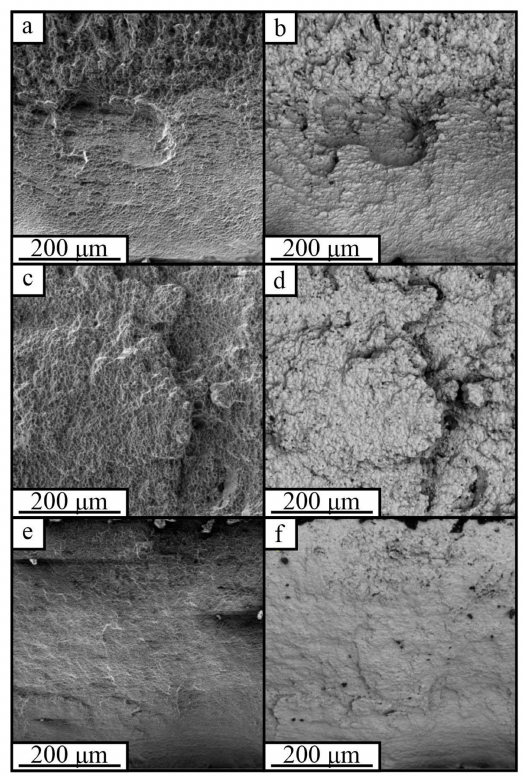
Figure 15. SE/BSE-images of fracture surfaces obtained from sample 1 ( a , b ), 2 ( c , d ), and 3 ( e , f